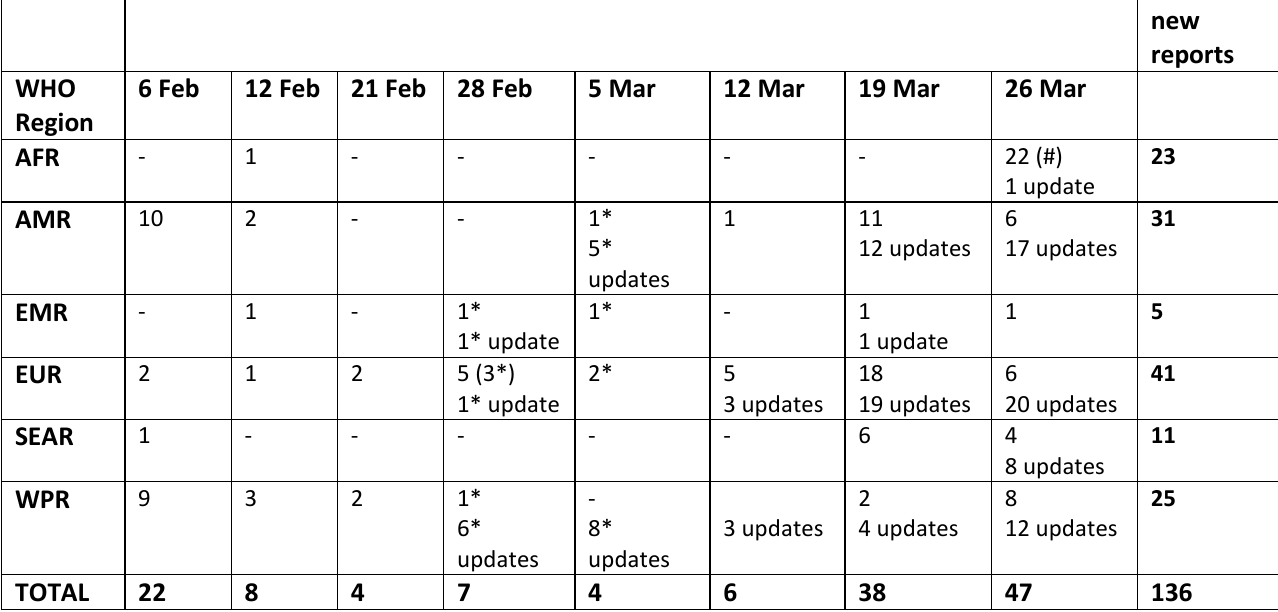
Table 1. Number of States Parties officially reporting additional health measures that significantly interfere